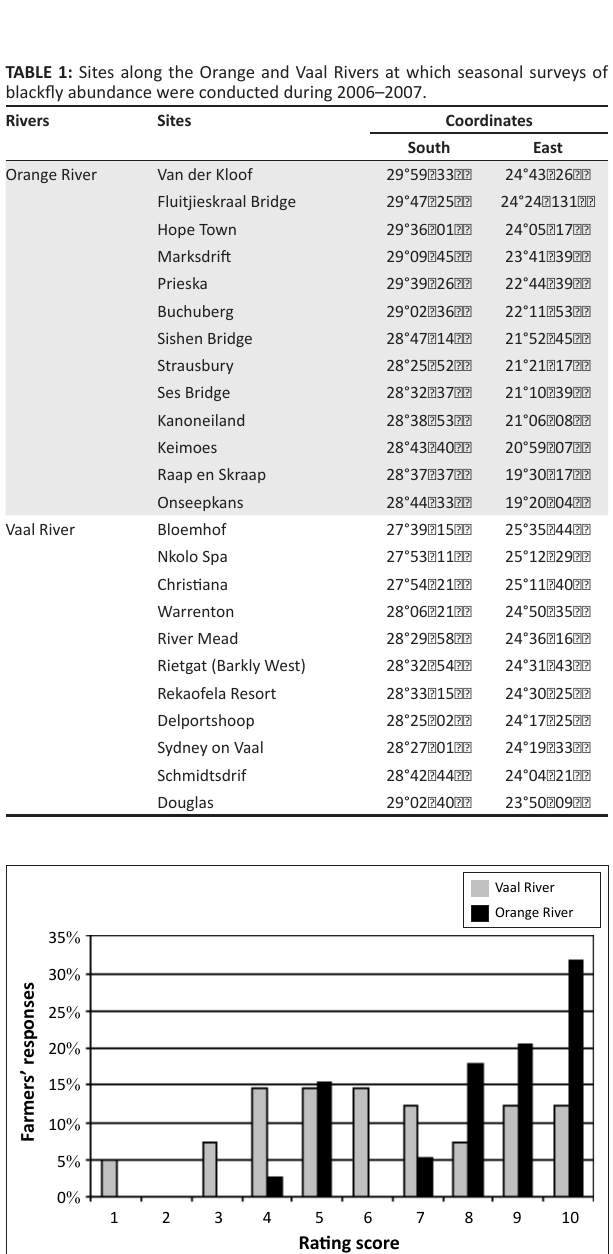
FIGURE 2: Percentage of farmers experiencing blackfly annoyance levels (scaled on a rating of 1–10 for increasing severity) along the Orange and Vaal Rivers.